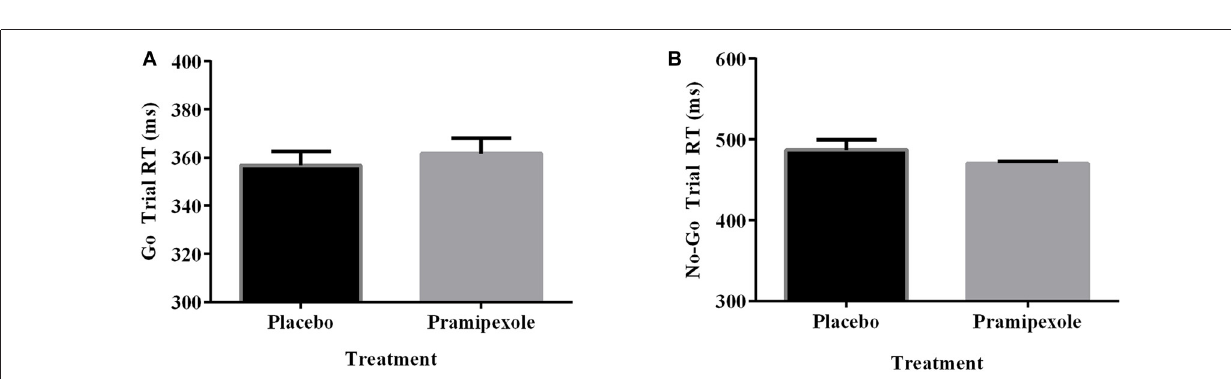
FIGURE 3 | Reaction time (RT; ms) for Go trials and No-go trials during the Go No-go task for healthy participants treated with either standard placebo or 0.5 mg pramipexole ( N = 20). Both variables were analyzed with two-tailed t -tests. Data represent mean ± SEM. (A) No significant differences between placebo and pramipexole groups were found for Go trial RT ( p > 0.05). (B) No significant differences between placebo and pramipexole groups were found for No-go trial RT ( p >